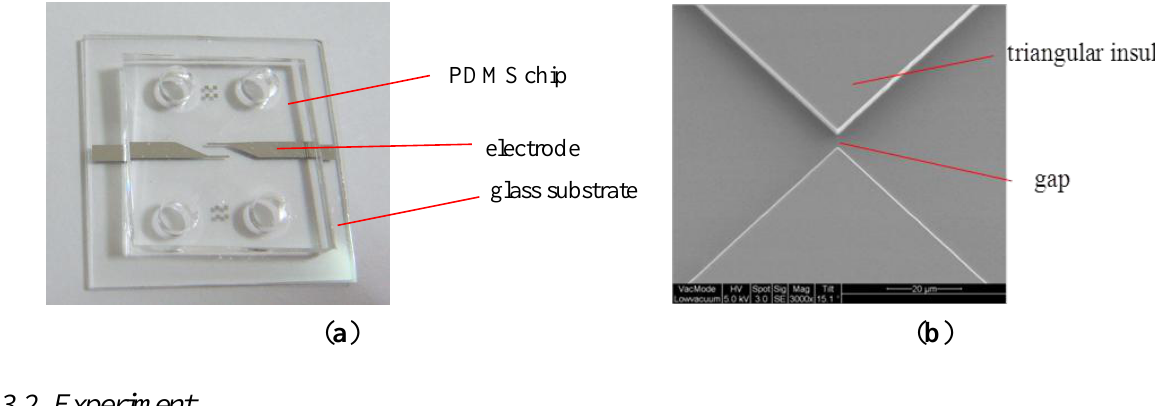
Figure 2. ( a ) A photograph of an assembly of an EDEP-based chip. ( b ) An optical microscope image of the triangular insulating structures with a 5 μm constriction